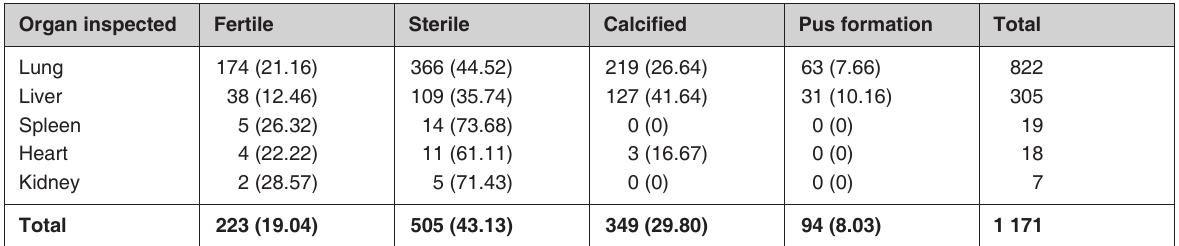
TABLE 2 Viability of hydatid cysts according to the affected organs from cattle slaughtered at the Jimma municipal abattoir ( n =